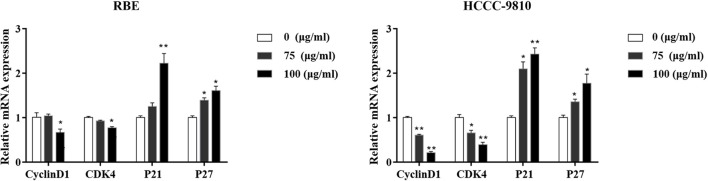
Effect of curcumol on the expression of the cell cycle associated molecules in RBE and HCCC-9810 cells. Curcumol decreased the mRNA level of cyclinD1 and CDK4, while it increased the expression of P21 and P27. *P < 0.05, **P < 0.01, vs. control cells. GAPDH was used as internal controls.